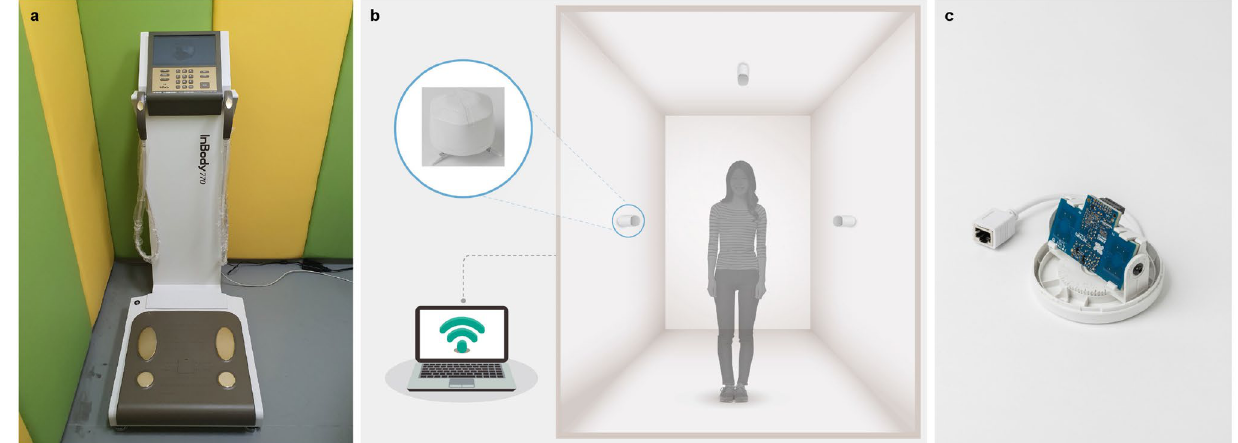
Figure 1. Overall experimental environment for data collection. ( a ) BIA (InBody 720), ( b ) radar sensor settings, and ( c ) IR-UWB radar chip (XK350-120 W0) covered with a plastic